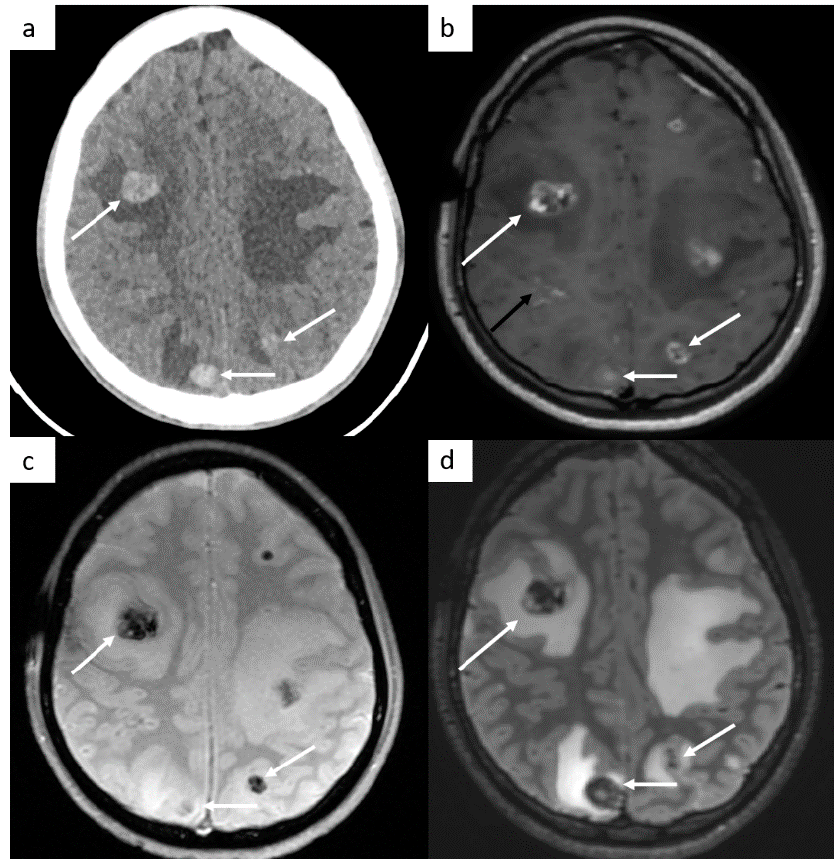
Figure 3. Brain metastases. Cerebral CT brain demonstrates several hemorrhagic metastases ( a ). MRI confirms the presence of several metastases with peripheral enhancement ( b , white arrows). They are hypointense on SWI-weighted images ( c ), with surrounding edema ( d ) on FLAIR-weighted images. In this case, a leptomeningitis is associated ( b , black arrow).